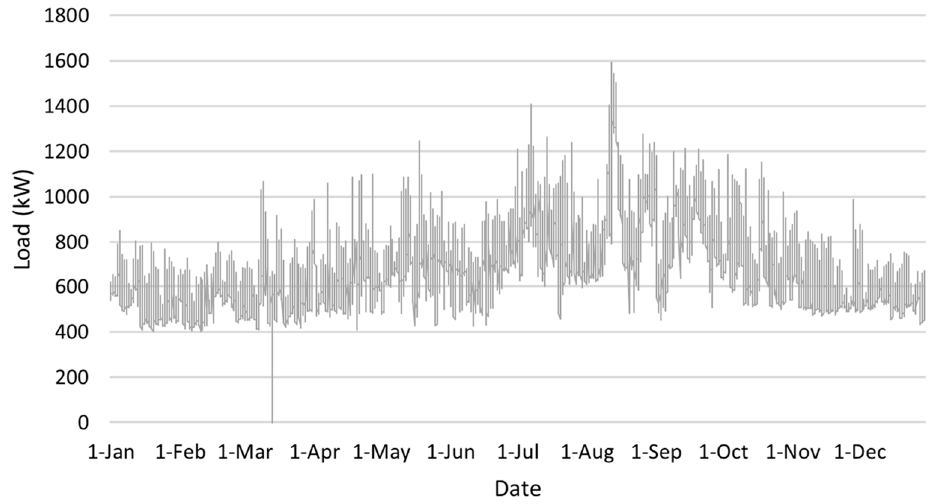
Figure 4. CDH hourly peak load, 2016.